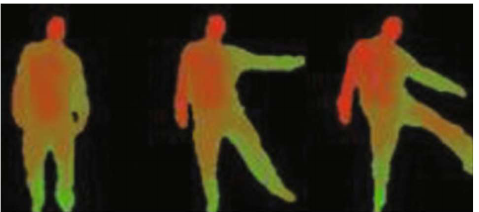
Figure 18. Samples from MSR Action 3D dataset [63].